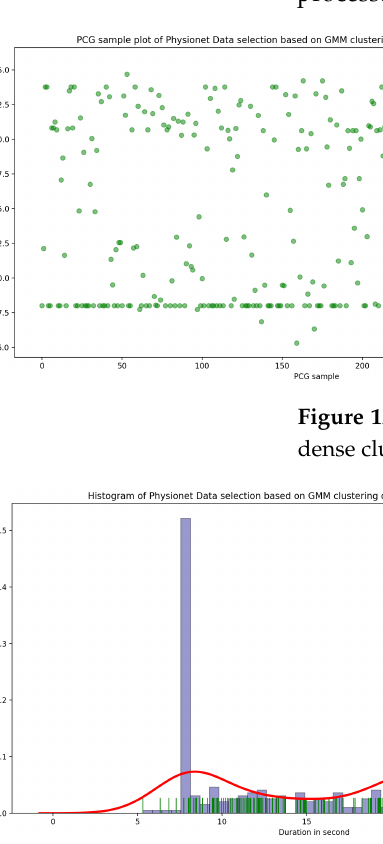
Figure 13. An overview of KDE curve in function of duration for normal and abnormal PCG classes after GMM data selection